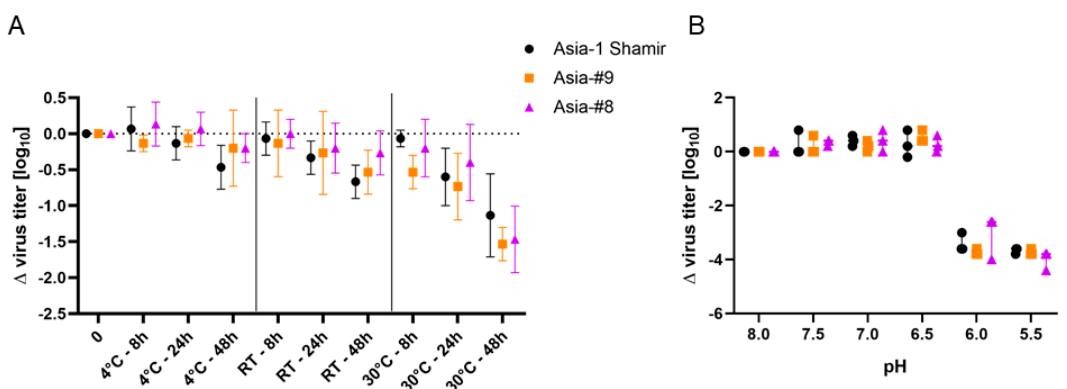
Figure 3. Temperature and pH stability of Asia-1 Shamir, Asia-#8 and Asia-#9. Viruses were kept at neutral pH at 4 °C, RT and 37 °C for 8, 24 and 48 h ( A ) as well as at room temperature in buffered solutions at pH 8.0, 7.5, 7.0, 6.5, 6.0 and 5.5 for 30 minutes ( B ). Values on the y-axis represent the reduction in titer compared to time point zero ( A ) or to the virus incubated at pH 8.0 (Figure 3B). All experiments were independently performed three times.